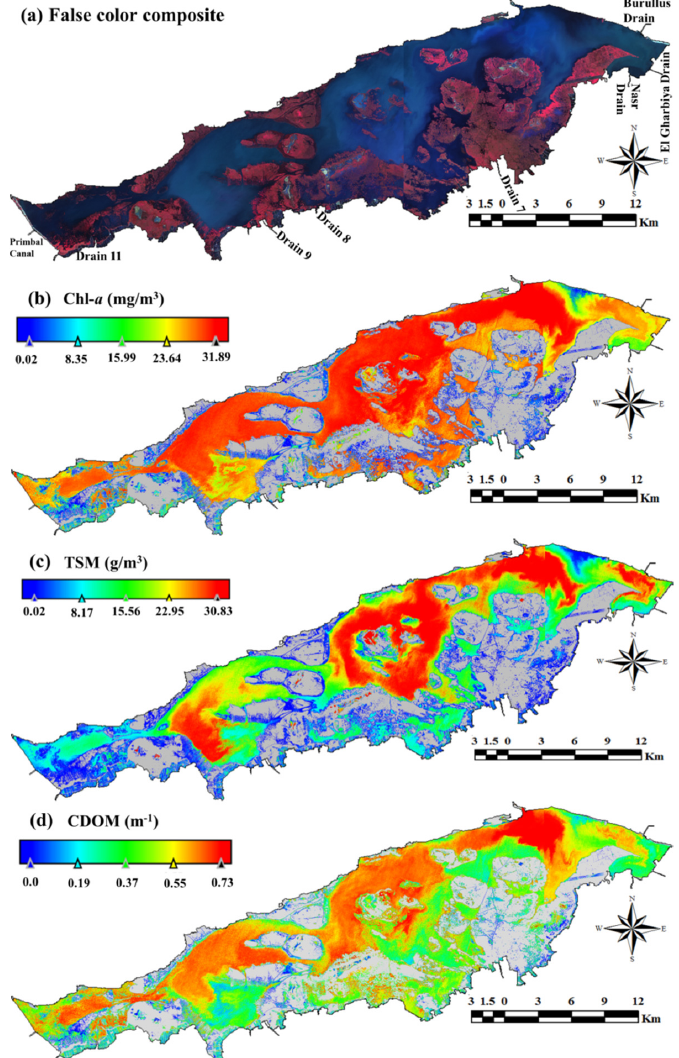
Figure 7. Maps showing ( a ) Sentinel-2 MSI False color composite (RGB = B8 B4 B3) with water shown in blue and hydrophytes of the emergent aquatic plants in red along with the C2RCC water quality parameters of ( b ) Chl- a , ( c ) TSM, and ( d ) CDOM content. Masked areas are shown in gray color.